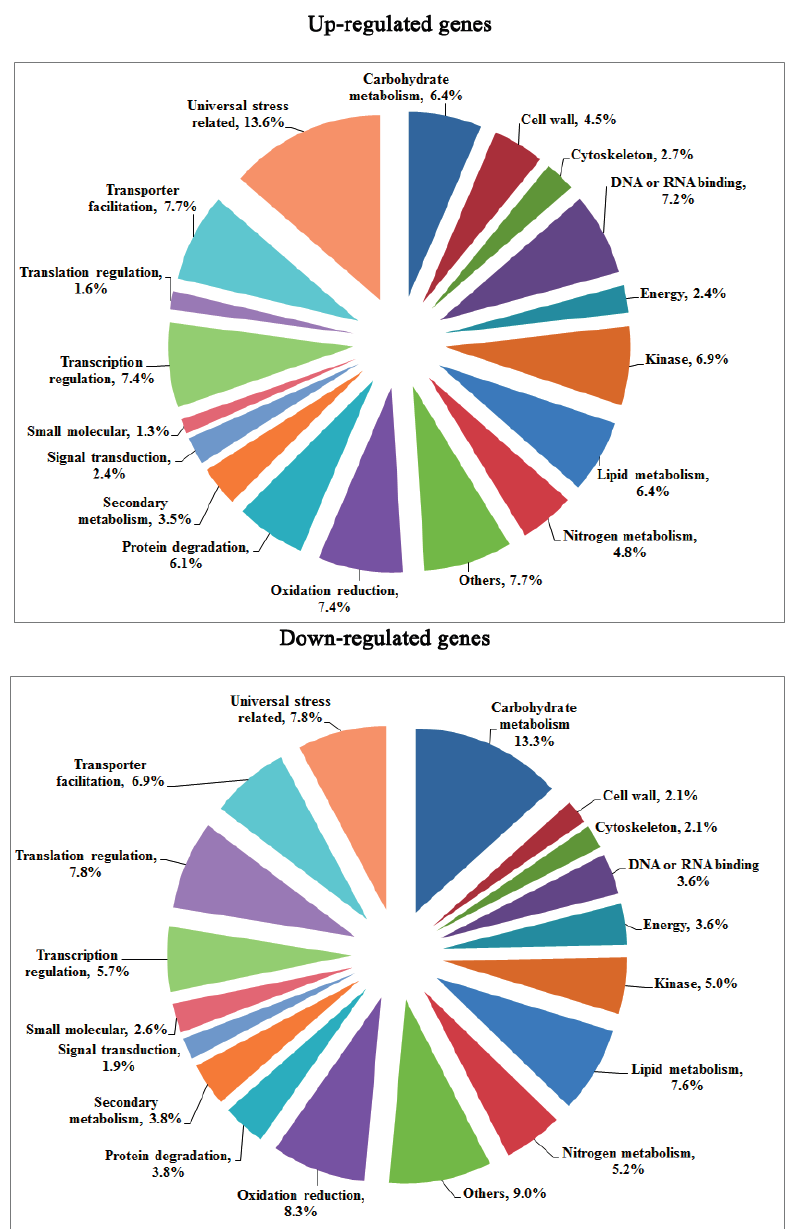
Figure 4. Functional categorization of up-regulated and down-regulated genes. This analysis did not include the genes with “unknown